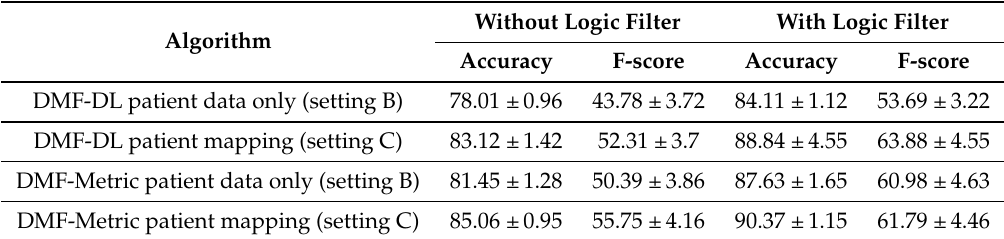
Table 3. Classification results with settings B and C from Figure 6. Without Logic Algorithm